Question: Summarize what this figure shows in one sentence.
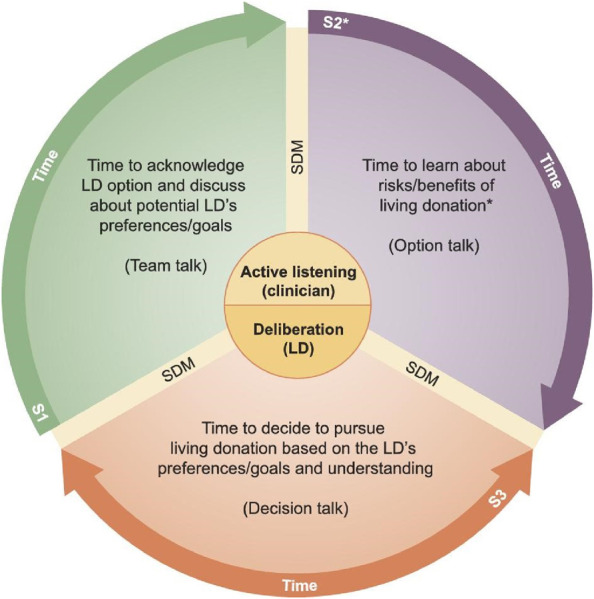
Answer: Shared decision-making should start with the primary nephrologist prior to the need for kidney replacement therapy or at the local dialysis unit (S1), and, at the transplant center, with transplant clinicians and surgeons throughout the process of evaluation (S2) and prior to nephrectomy (S3). *S2 should not be intended as a single educational session but as a combination of two or more sessions (depending on the LD’s health literacy, intellectual capacity, need for information and/or additional clarification) combining the use of various decision aids to improve understanding. S, step; SDM, shared decision-making (reproduced from reference 9, under CC BY 4.0).